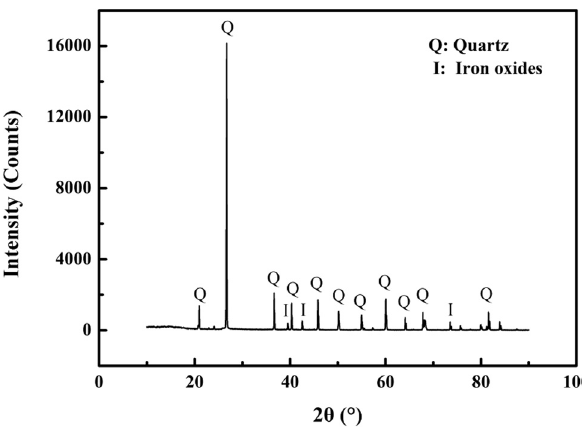
Figure 1: The X - ray di ff ractogram of quartz samples.